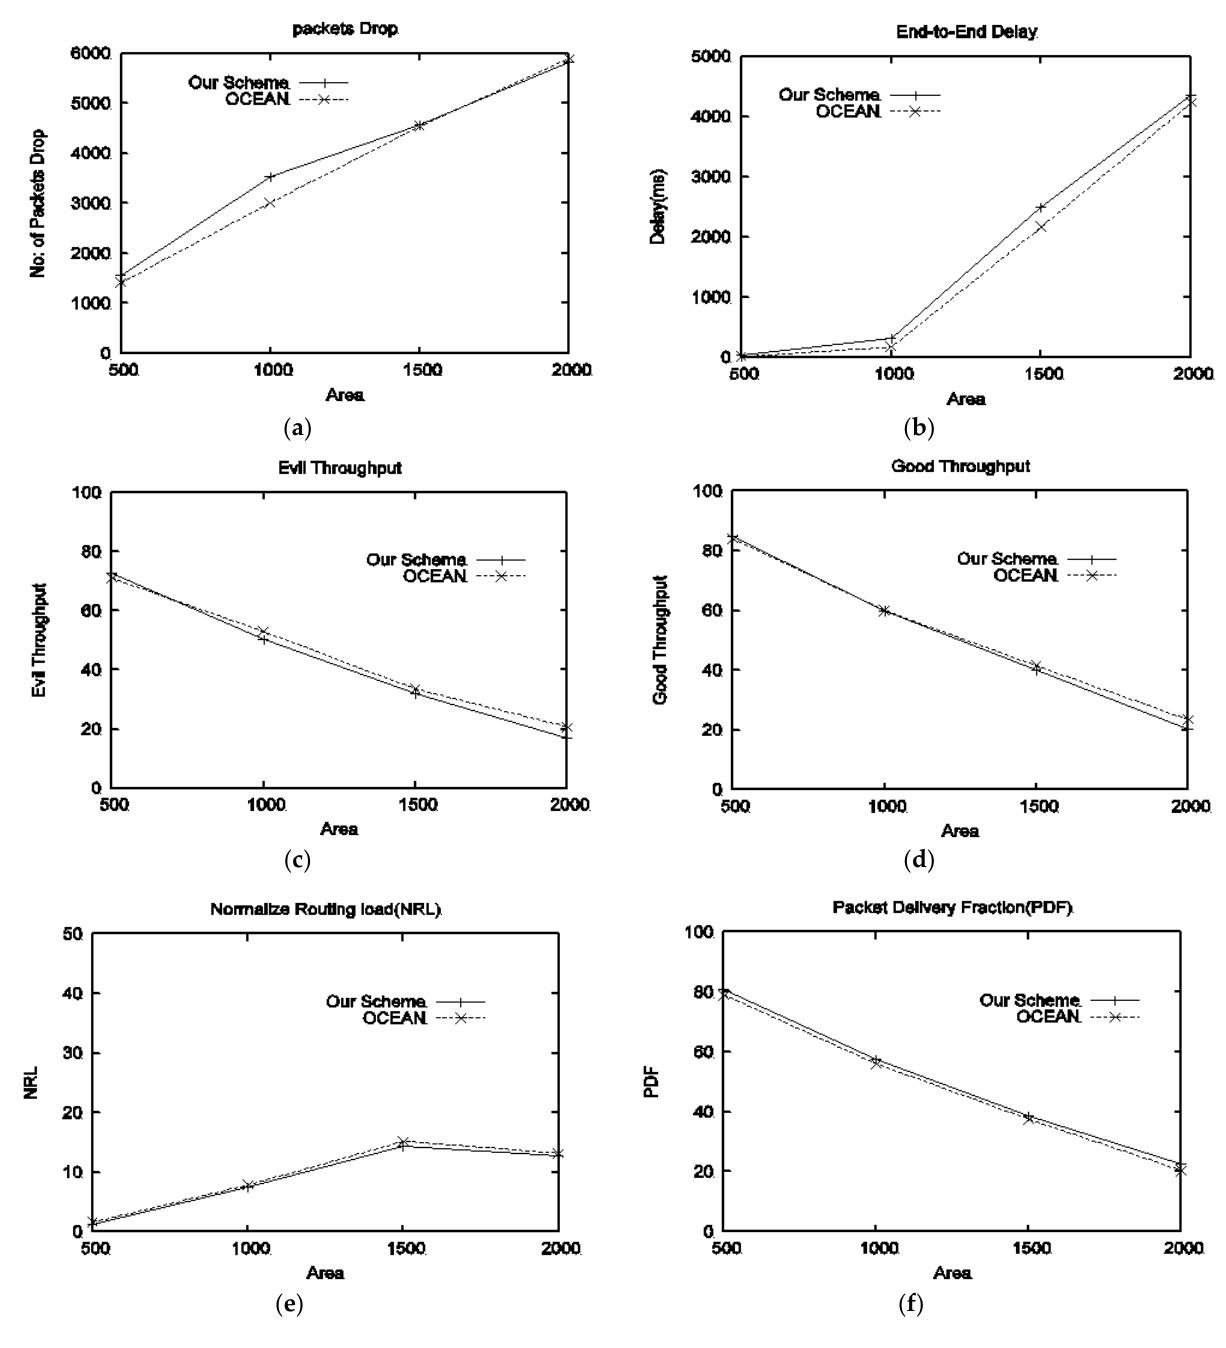
Figure 2. Performance of the proposed scheme with respect to different sizes of the area against type-I attackers: ( a ) drop packets vs. area, ( b ) delay vs. area, ( c ) evil throughput vs. area, ( d ) good throughput vs. area, ( e ) NRL vs. area, ( f ) PDF vs.